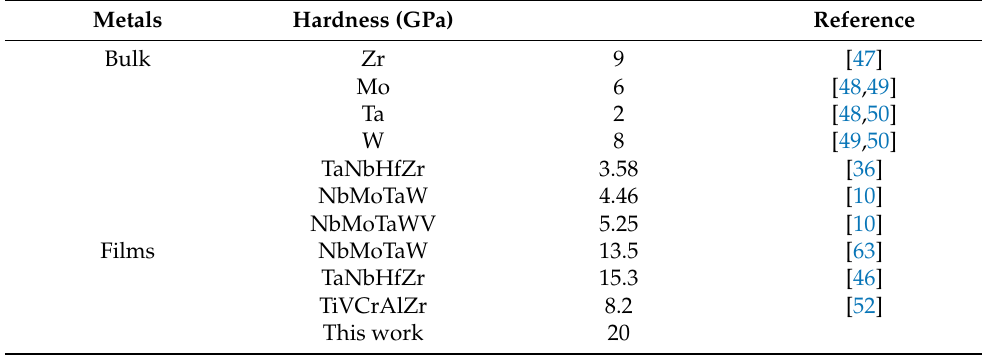
Table 7. The hardness values of refractory metals, RMPEAs blocks, and RMPEAs thin